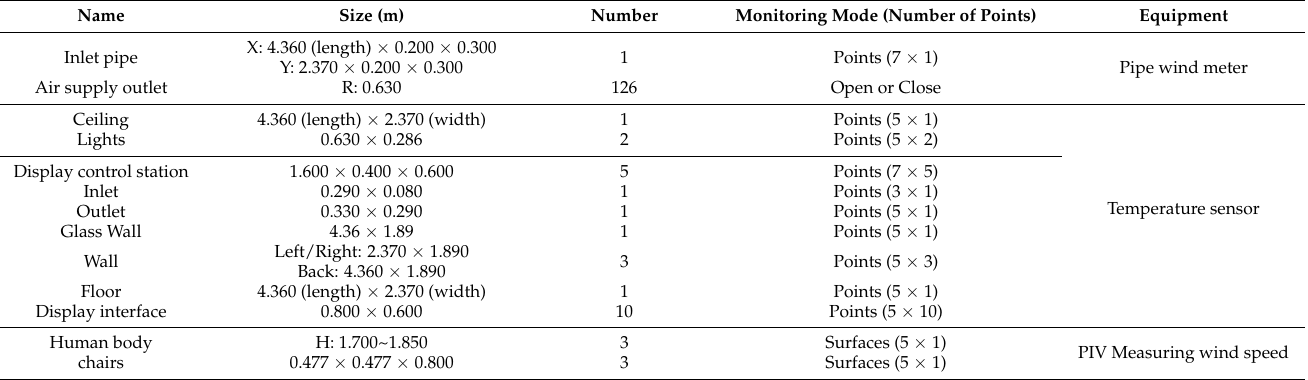
Table 1. Structural dimensions of all equipment in the